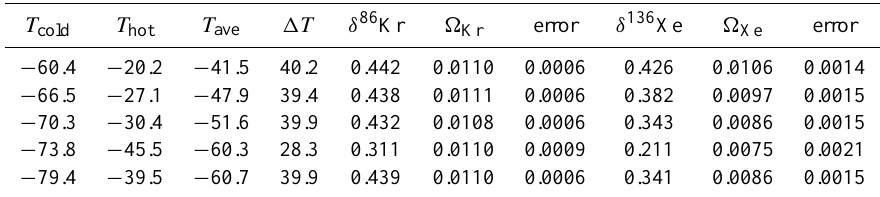
Table A1. Thermal diffusion coefficients for Kr and